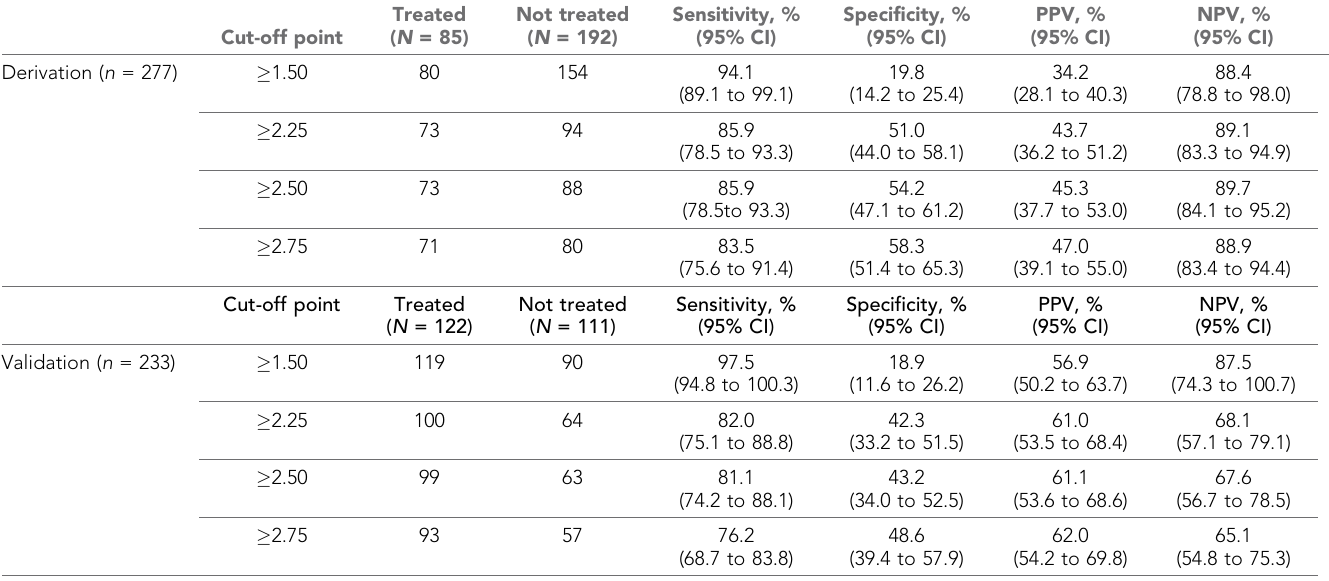
Table 5. Different cut-off points for the clinical prediction